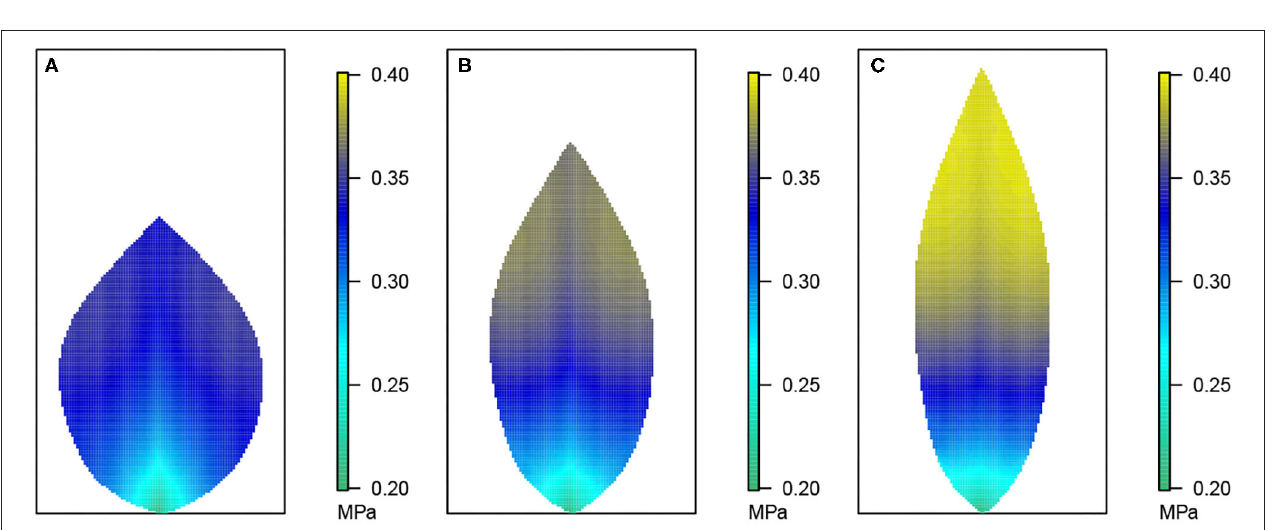
FIGURE 4 | Leaf area distribution of hydraulic pressure in the phloem network. (A) Wide leaf, (B) reference leaf, and (C) narrow leaf. Details as in Figure 3